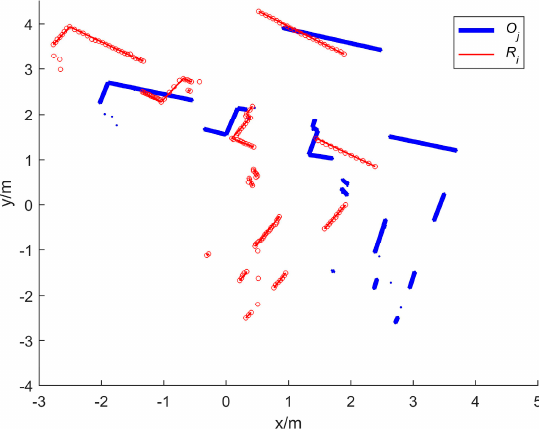
Figure 5. E ff ect diagram of line feature extraction. Figure 5. Effect diagram of line feature